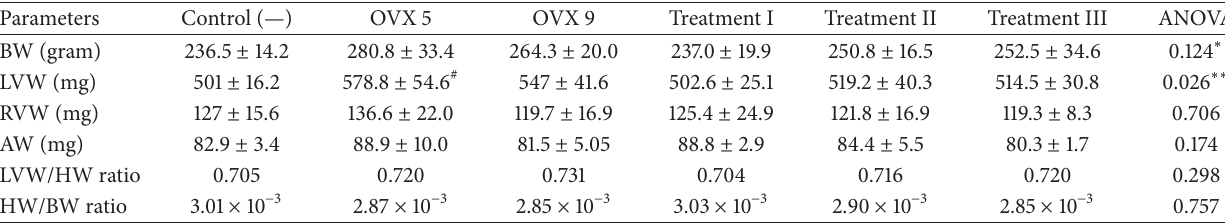
Table 1: Measurements of heart